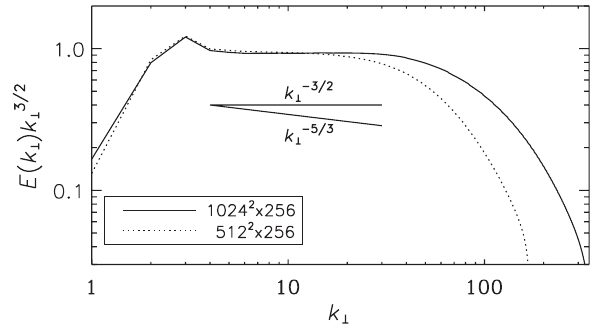
FIG. 2. Total field-perpendicular energy spectrum in balanced MHD as the Reynolds number increases (cases MB1 and MB2 in Table I).